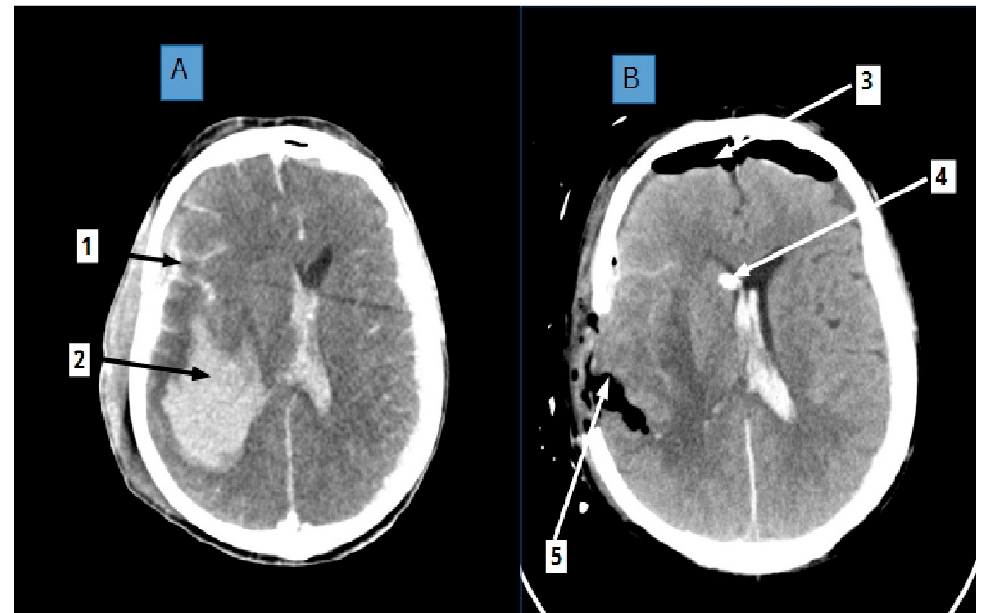
Figure 2. 56 years old male, a victim of craniocerebral trauma (CT) due to assault. Assessment upon admission rated him at a 3 GCS (Glasgow Coma Scale) without autonomic respiration. CT A : showing huge intracerebral hematoma in right hemisphere (arrow 2) surrounded with edematous area. Subarachnoid hemorrhage (arrow 1) as well as intraventricular blood clot. Right-sided craniectomy was performed and hematoma evacuated. Intraventricular external drainage was installed. CT B : shows postoperative cavity with air remnants (arrow 5), intraventricular catheter tip in right frontal horn is also seen (arrow 4). Air in subarachnoid space in frontal region is present due to brain volume reduction (arrow 3). Noteworthy is that the shift of medial line structures is less advanced compared with CT A taken before surgery. The patient survived with the GOS (Glasgow Outcome Scale), which might be related to the early application of decompressive techniques e.g., craniectomy and increased CSF outflow causing more adequate perineuronal net geometry. The study was conducted in accordance with the Declaration of Helsinki, and the Bioethical Commission of Pomeranian Medical University in Szczecin, Poland, approved the protocol (permission numbers KB-0012 / 156 /